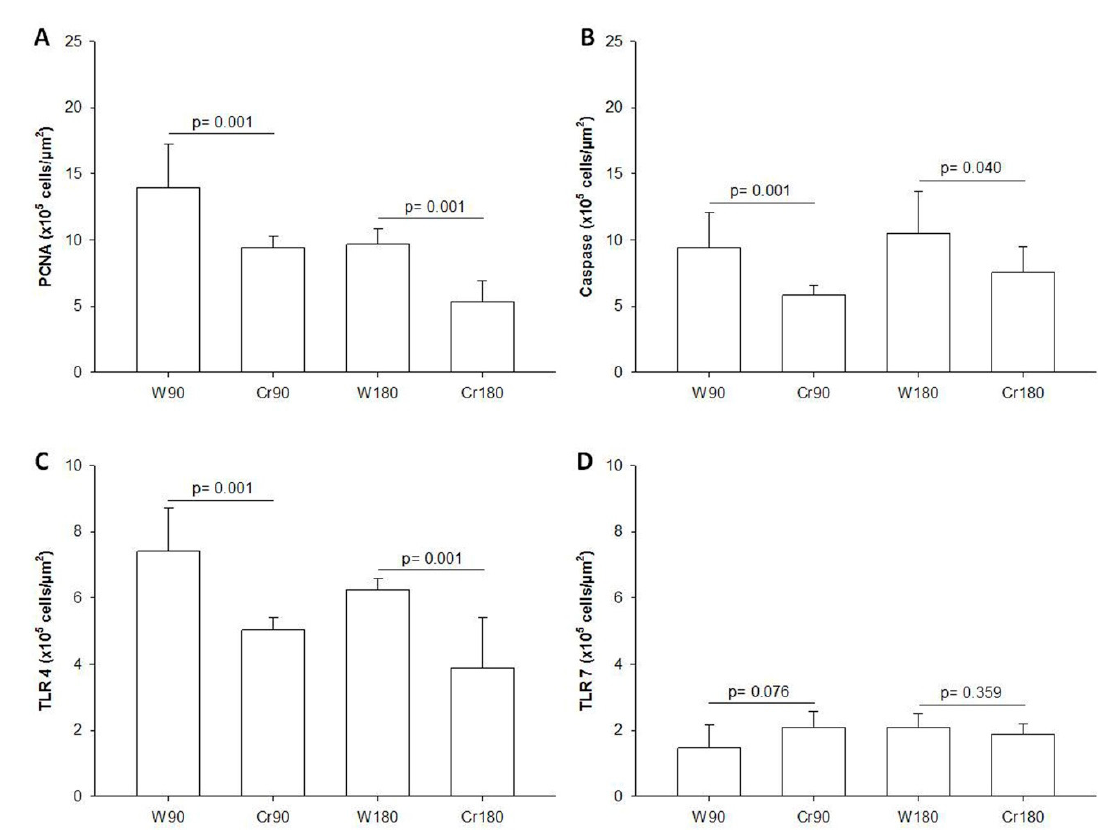
Figure 5. Proliferation, apoptosis and toll-like receptors 4 and 7 in the lung parenchyma. W90, control / water + 90 min of ischemia; Cr90, creatine + 90 min of ischemia; W180, control / water + 180 min of ischemia; Cr180, creatine + 180 min of ischemia. ( A ) Proliferation; ( B ) apoptosis; ( C ) toll-like receptor 4; ( D ) toll-like receptor 7. Data are expressed as mean and standard deviation ( n = 8 animals/group).